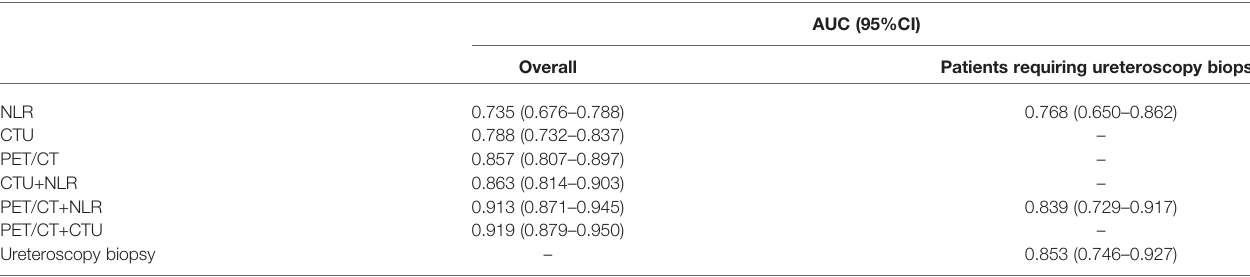
TABLE 4 | Evaluation of predictive power of various methods to diagnose malignant lesions of UUT using ROC curve.